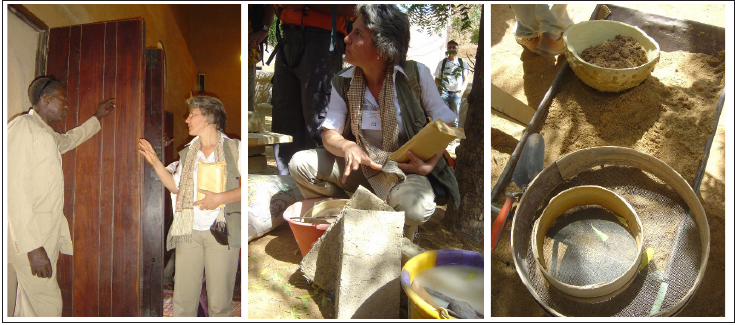
Figure 14: Architect Gisele Taxil-Wardell explains the construction process and conservation work done in the building of the Great Mosque of